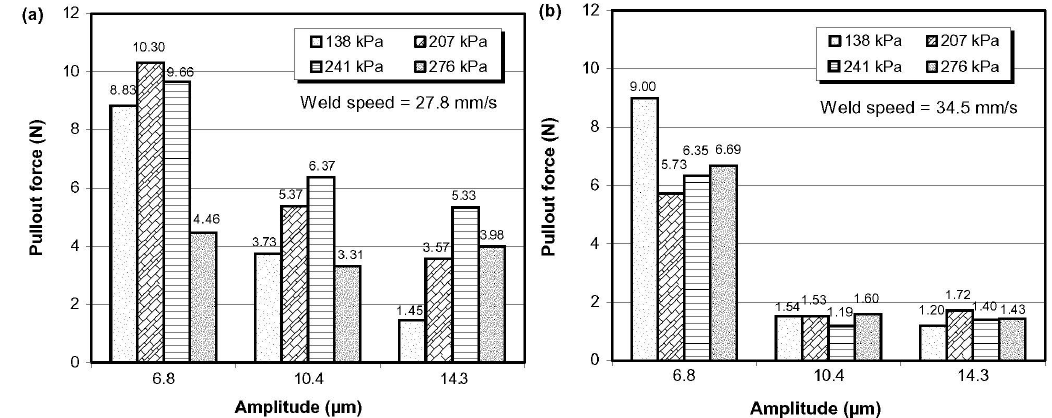
Figure 15. Fiber pullout test result of specimens consolidated at ( a ) 27.8 mm/s and ( b ) 34.5 mm/s, respectively [7].